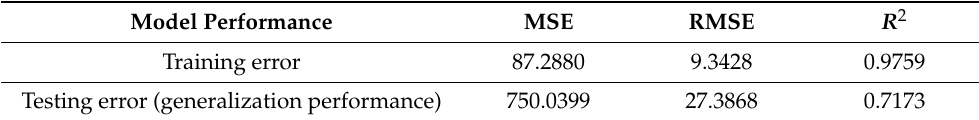
Table 13. The performance of the optimal CART